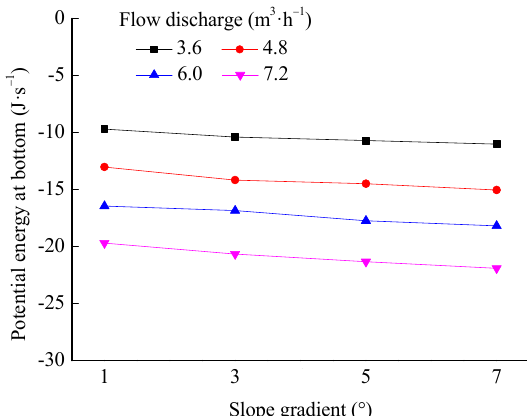
Figure 6. Potential energy at the bottom of the downstream gully bed under different slope gradi ‐ ents and flow discharges.